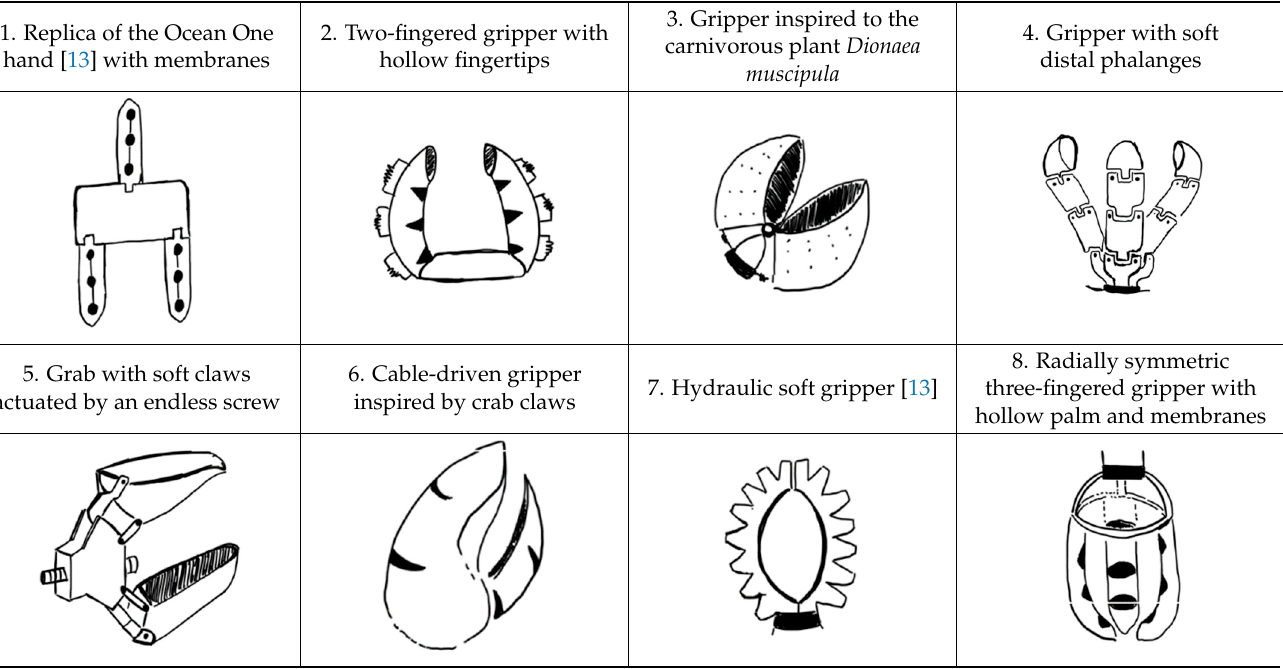
Table 3. Decision matrix for the design of the underwater gripper presented in this work. The concept design ideas are evaluated with respect to a reference design, then weighted using the stakeholders ratings, which reflect the relative importance of individual requirements. The final score is obtained by summing the totals weighted for all stakeholders.